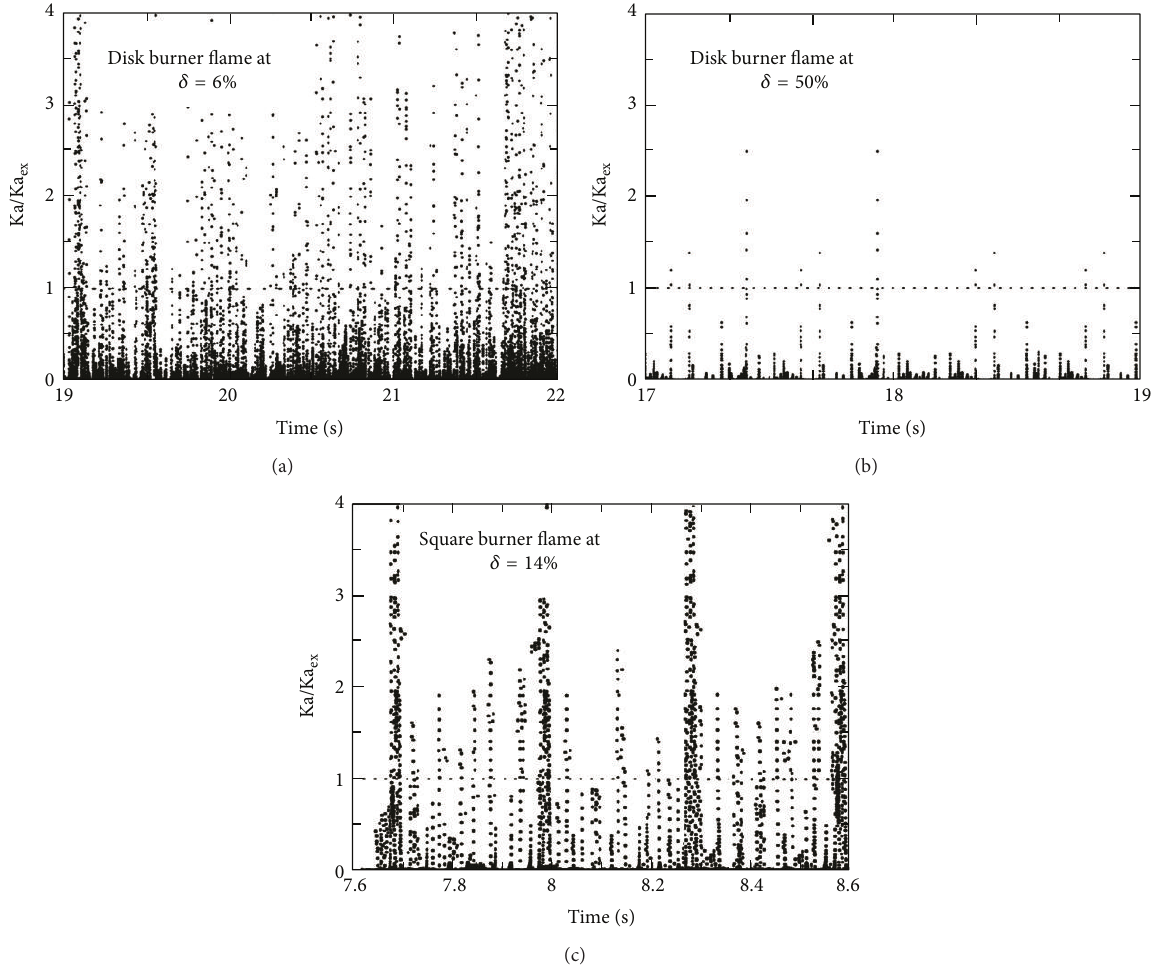
Figure 8: Scatterplots of the normalized Karlovitz number for the disk ((a), (b)) and the square (c) at different levels of local extinction ( Λ = Ka/Ka ex values limited to 4 for clarity of extinction events signified by values greater than 1).